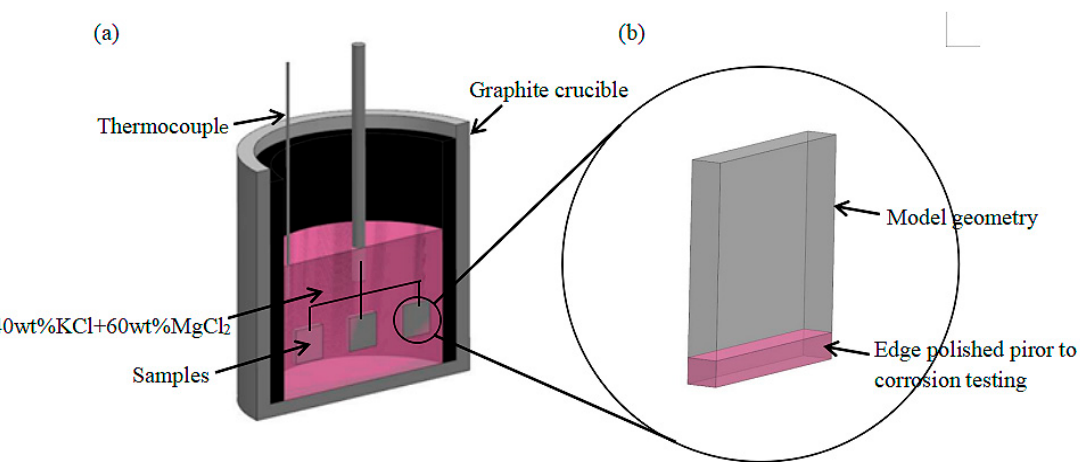
Figure 1. Schematic diagram of molten ‐ salt corrosion. ( a ) Schematic diagram of the molten ‐ salt corrosion test device and alloy sample. ( b ) Polishing area.